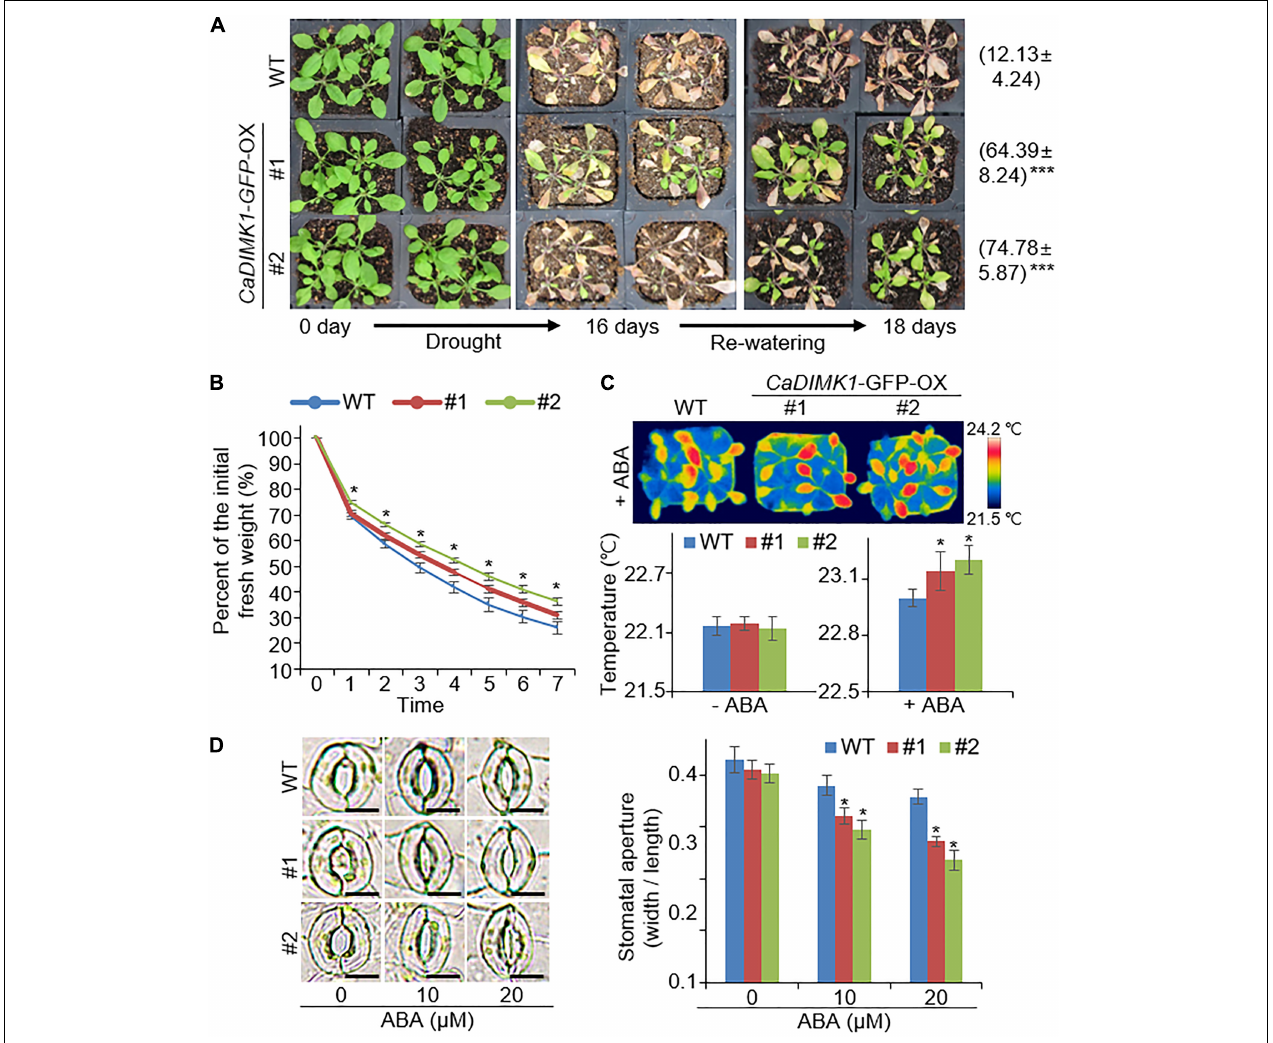
FIGURE 6 | Increased drought stress tolerance of CaDIMK1 -overexpressing (OX) plants. (A) Drought-tolerant phenotype of CaDIMK1 -OX plants. Wild-type (WT) and CaDIMK1 -OX Arabidopsis plants were cultivated for 3 weeks under well-watered conditions (left). Arabidopsis was exposed to drought stress by withholding watering for 16 days (middle), followed by 2 days after rewatering (right). The survival rates were counted 2 days after rewatering. Values are mean ± SE with three independent experiments ( n = 42). (B) Transpiration water loss from wild-type and CaDIMK1 -OX plant leaves during 7 h after leaf detachment. (C) Increased leaf surface temperatures of wild-type and CaDIMK1 -OX Arabidopsis plants treated with 50 µ M ABA at 0 and 4 h. Values are mean ± SE with three independent experiments ( n = 10). (D) Reduced stomatal opening in wild-type and CaDIMK1 -OX transgenic plants treated with ABA. The stomata with guard cells were taken using a microscope when the stomatal pore size was measured. Leaves were incubated in stomata opening solutions with 0, 10, or 20 µ M ABA. Values are mean ± SE with three independent experiments ( n = 20). Asterisks indicate statistical differences between the wild-type and the transgenic plants according to Student’s t -test (* P < 0.05). The scale bar represents 10 µ